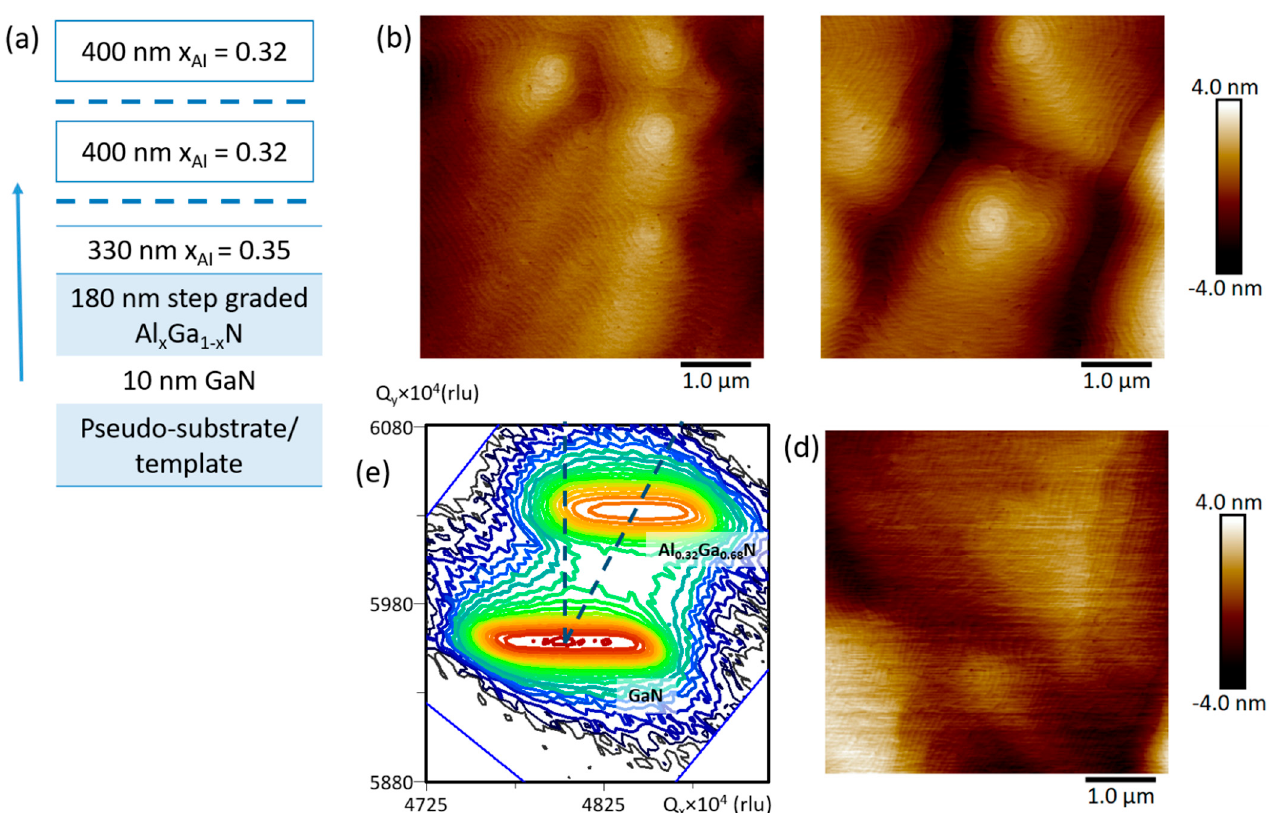
Figure 3. ( a ) Schematic of the first structure grown on porous GaN. The x Al is obtained from RSM, and the dashed lines indicate regrowth interfaces. 5 × 5 µm 2 AFM height images of ( b ) initial ~500 nm AlGaN; ( c ) after first regrowth (corresponding to d total ~900 nm AlGaN); ( d ) after second regrowth (d total ~1.3 µm AlGaN) showing good surface morphology. ( e ) RSM obtained from XRD with the GaN and 1.3 µm AlGaN peaks marked shows that Al 0.32 Ga 0.68 N is fully relaxed. The vertical dashed line running up each scan from the GaN peak shows the strain line while the other dashed line is the fully relaxed line.